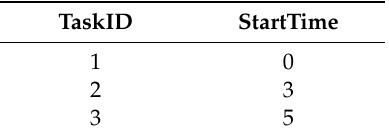
Table 3. Lo-criticality mode dispatch table for the task set example in Table 1.